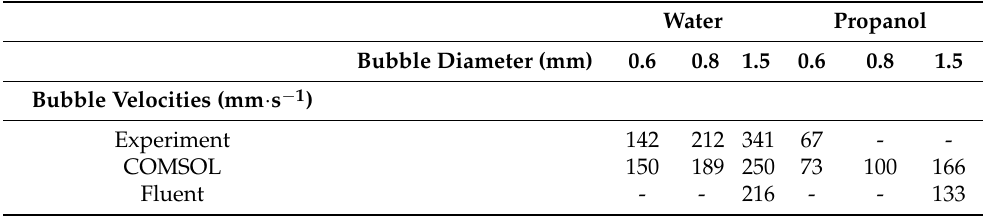
Figure 5. Comparison of the bubble shape deformation evolution in COMSOL and Fluent during the calculation time when rising in water, compared to steady-state shapes obtained from experiment and theory. D b = 1.5 mm. Obtained results from both CFD solvers and experimental measurements are clearly outlined in Table 2. Table 2. Summarized results from COMSOL, Fluent, and experiment for three bubble diameters (0.6, 0.8, and 1.5 mm) rising in pure water and